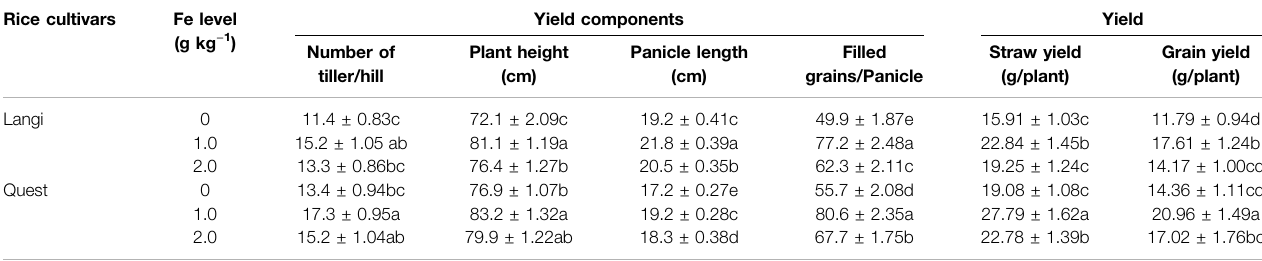
TABLE 4 | Effect of Fe addition in soil on yield components and yield of rice cultivar. Rice cultivars